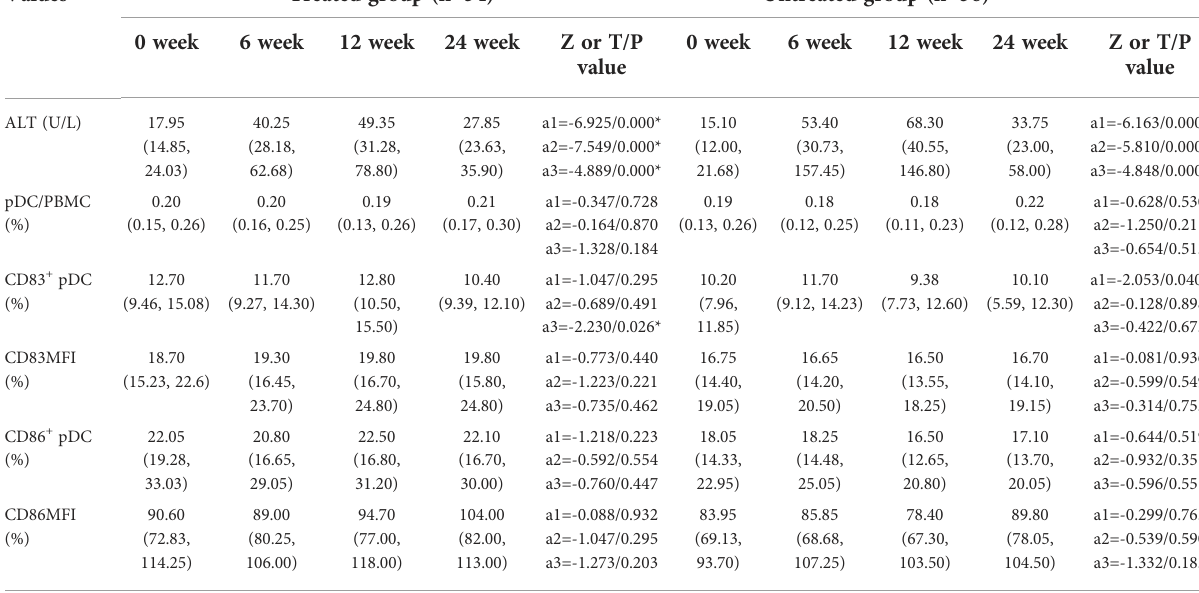
TABLE 3 The changes of postpartum ALT and pDC levels in Treated and Untreated group. Values Treated group (n=54)